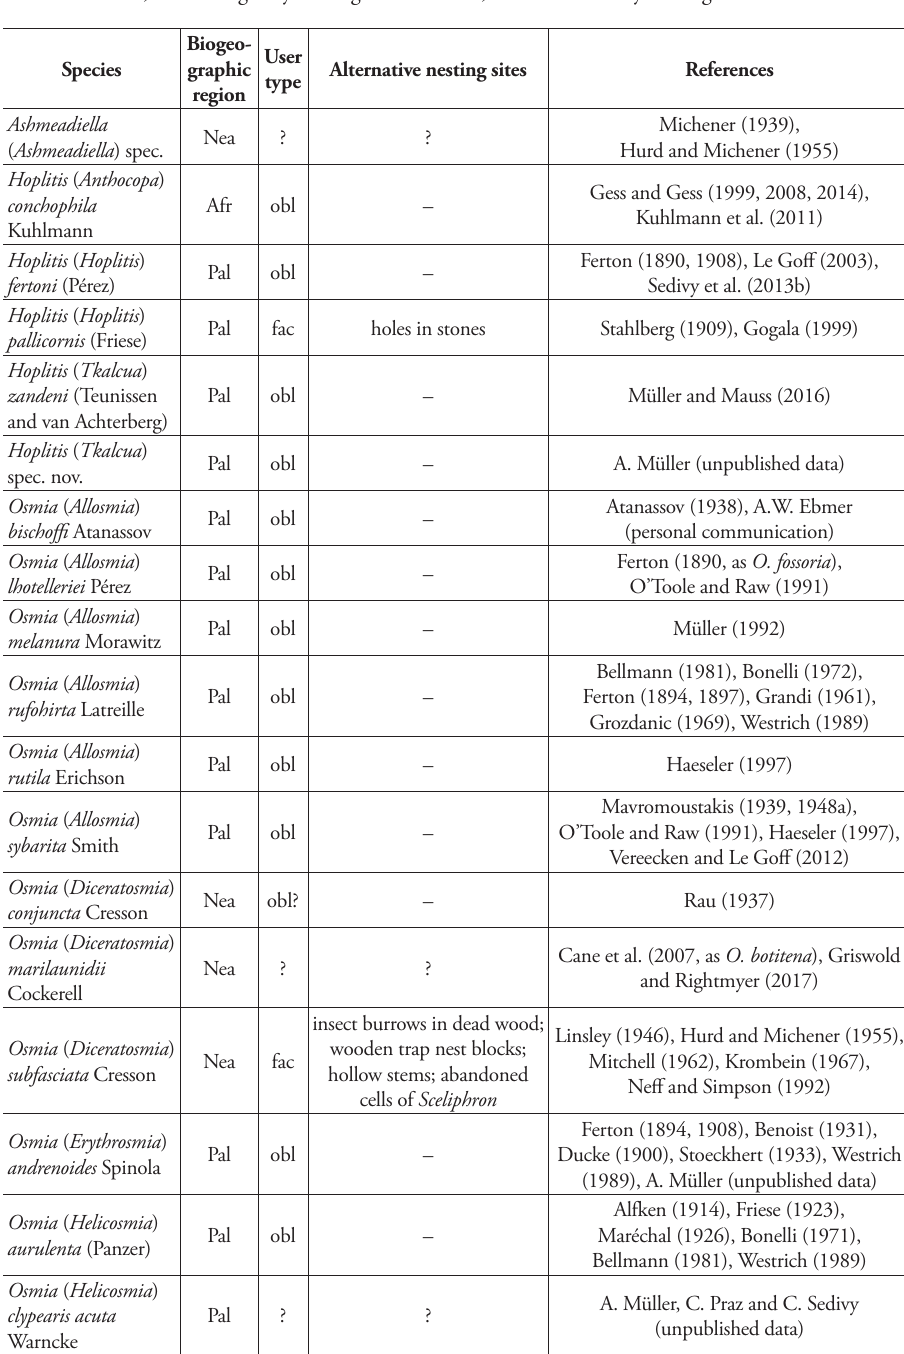
Table 3. Osmiine bee species recorded to nest in empty snail shells. Nea = Nearctic, Afr = Afrotropics, Pal = Palaearctic; obl = obligatory nesting in snail shells; fac = facultatively nesting in snail